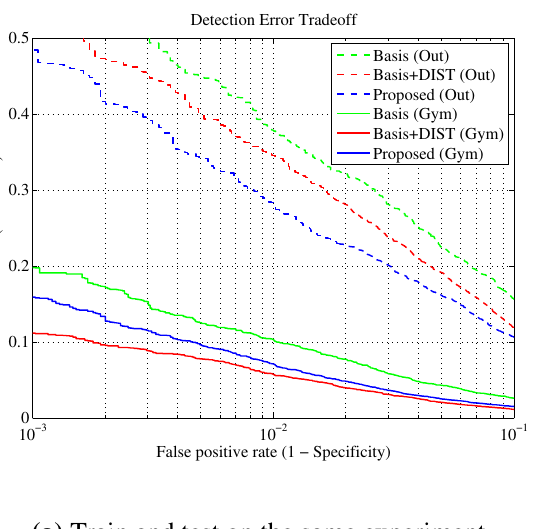
Figure 7. Laser feature sets—detection error tradeoff curves. In both figures, the green line corresponds to the basis feature set, the red line to the basis plus the distance features and the blue line to the proposed feature set. ( a ) The training and test sets are acquired from the split up of same experimental data: solid lines indicate the gymnasium and dotted lines the outdoors data sets, respectively. ( b ) Solid lines signify that the outdoor data set is used for training and its gymnasium counterpart for testing. Dotted lines signify the reverse